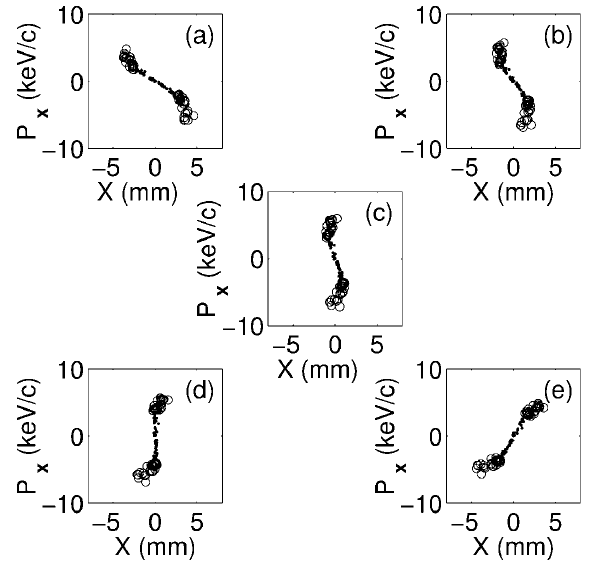
FIG. 8. Scatter plots of p x versus x at the s positions shown in Fig. 4. The high transverse momentum electrons (circles) and core electrons (points) are plotted with different symbols so that their progress may be traced near the